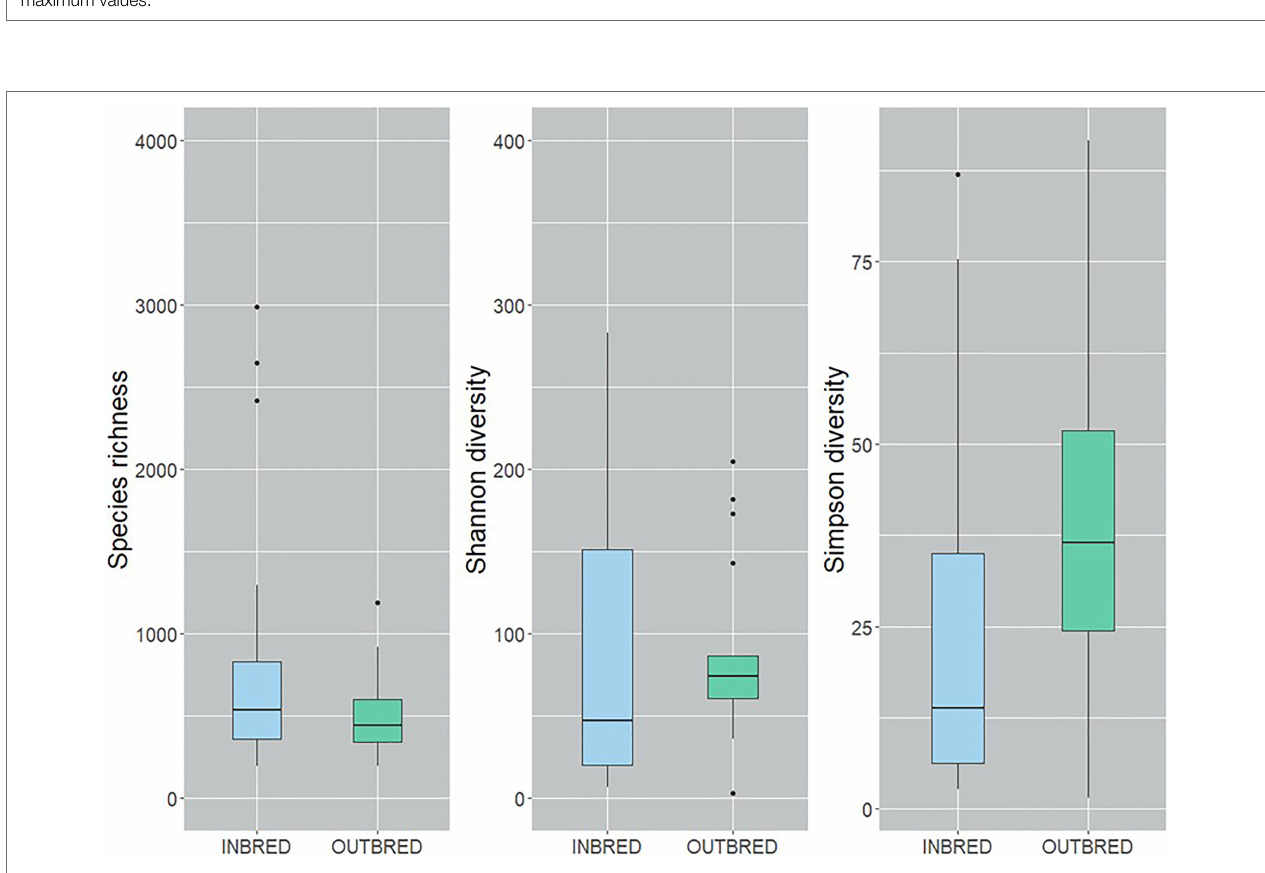
FIGURE 4 | Alpha diversity of the bacteria in the anterior intestine of the inbred and outbred groups of Nile tilapia. There is an increasing trend in the species richness of the inbred group ( p = 0.07). Simpson diversity shows an increasing trend in the dominant ASVs of the outbred group ( p = 0.06). The boxplots show minimum, lower quartile, median, upper quartile and maximum